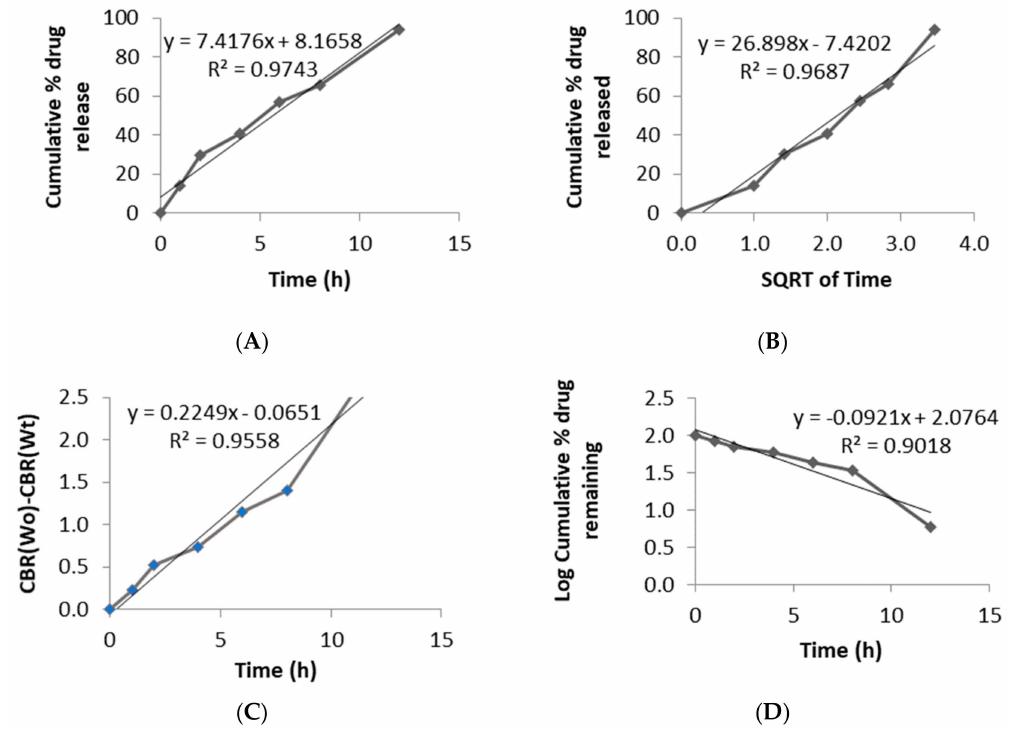
Figure 9. Drug release kinetics fitted to various models: Zero-order ( A ), Higuchi model ( B ), Hixon-Crowell model ( C ), and First-order ( D